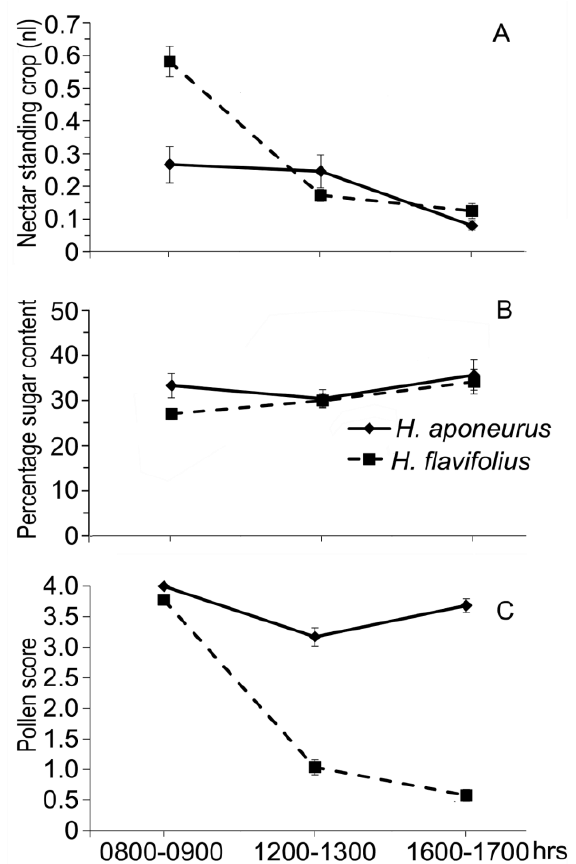
F IGURE 3. Change in floral resources for H. aponeurus and H. flavifolius as recorded in 2006 during three daily time periods at Mpala Research Centre. Graphs show A) nectar standing crop ( μ L / flower); B) nectar sugar concentration (% sugar); and C) pollen availability (as pollen score). Data points are grand means ± S.E. across all flowers (46 - 91 per species) and sampling dates (5 days for each species). The percentage of pollen remaining in anthers was scored on a scale of 0 - 4 (0 = < 1%; 1 = 1 - 25%; 2 = 26 - 50%; 3 = 51 - 75%; 4 = 76 -